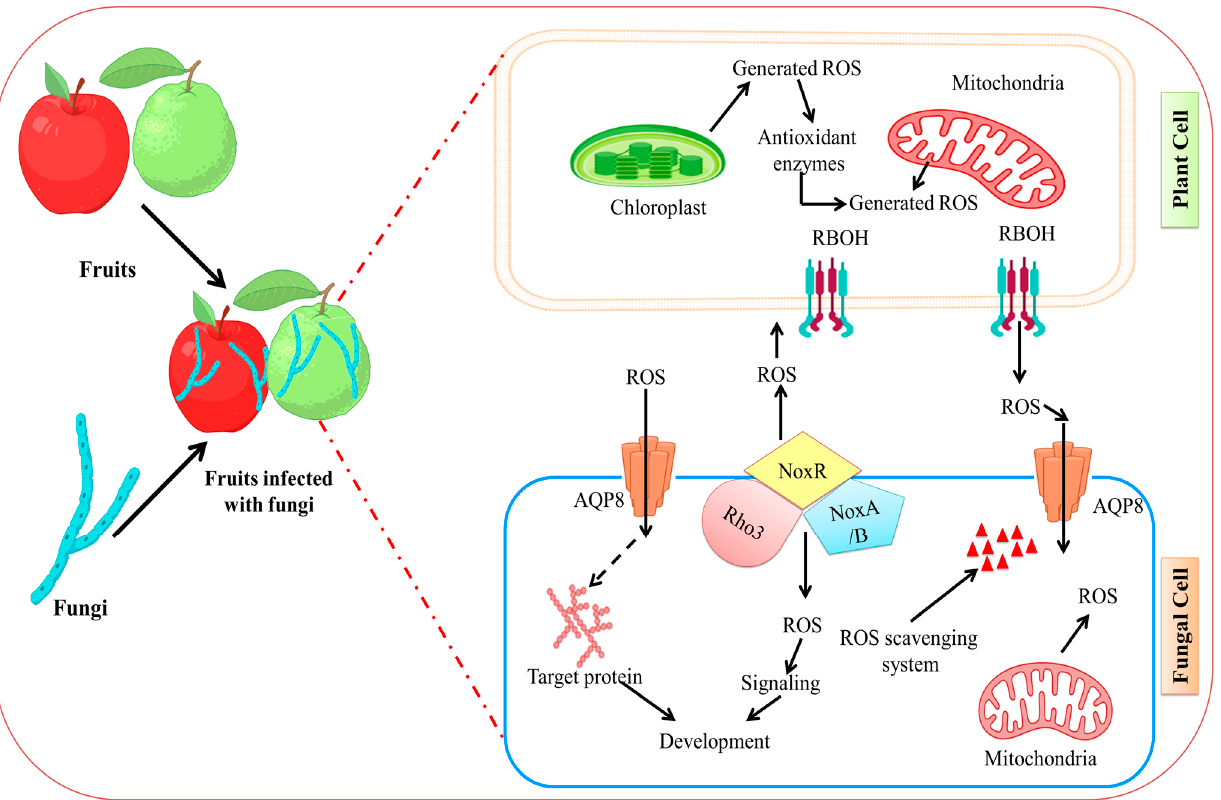
Figure 3. Fungal infection induced ROS generation in fruit. ROS signaling in fungal infections’ interactions with their plant hosts. In response to pathogen detection, plant cells release ROS via RBOHs in the plasma membrane and several intracellular organelles. Fungal hyphae generate ROS via Nox complexes, which are primarily found at the plasma membrane or endoplasmic reticulums and stimulate an oxidative burst response within the pathogen. Scavenging systems, which include both enzymatic and non-enzymatic systems, work together to maintain intra and extracellular redox homeostasis in both plants and pathogens. Figure created with